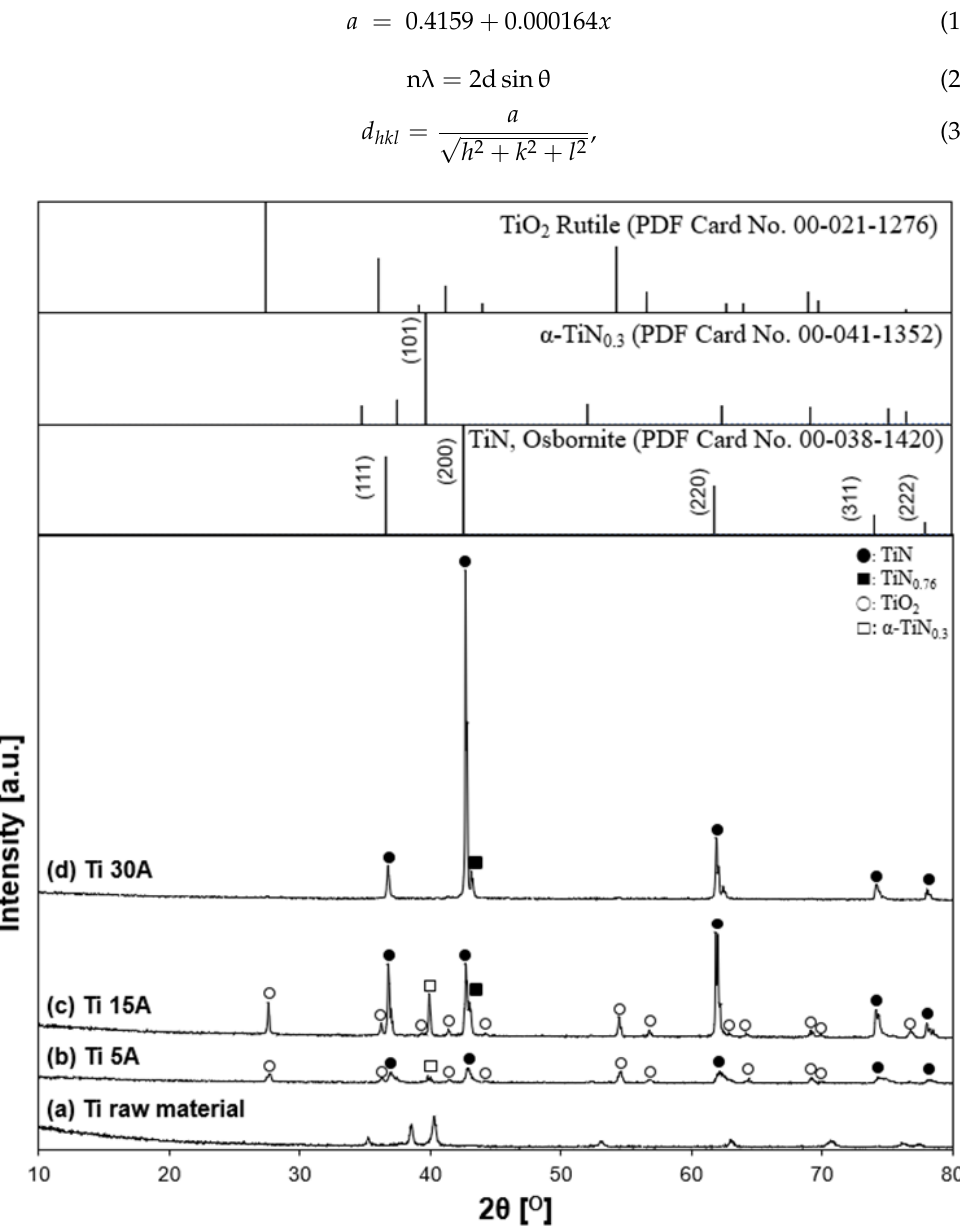
Figure 11. X-ray diffraction patterns of prepared samples. ( a ) Ti raw material, ( b ) Ti 5 A, ( c ) Ti 15 A, and ( d ) Ti 30 A. The inserted figure is the JCPDS PDF card of the TiN, TiN 0.76 , TiO 2 , and α-TiN 0.3 XRD patterns. Individual crystalline phases are represented by the following characteristic peaks: